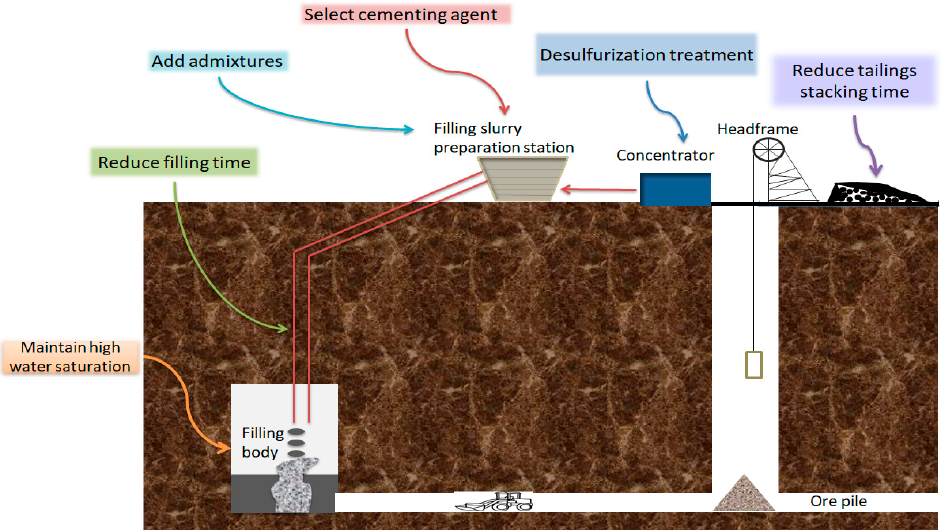
Figure 17. Regulation of filling process using sulfur